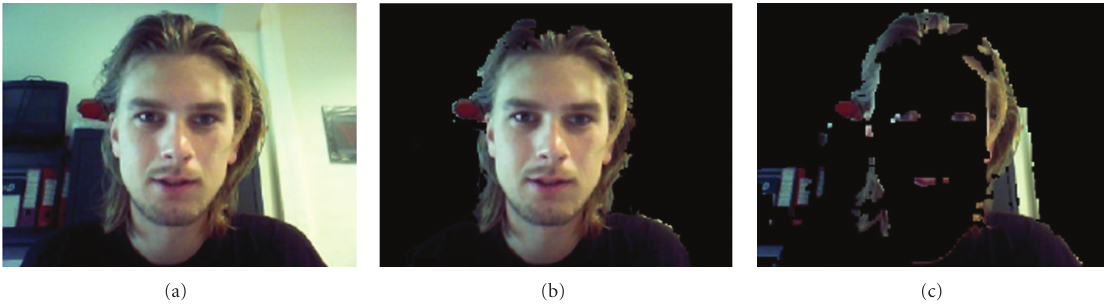
Figure 7: E ff ect of the visual attention parameter p : input image (a), detected salient objects with high values of p (b) and small values of p (c).